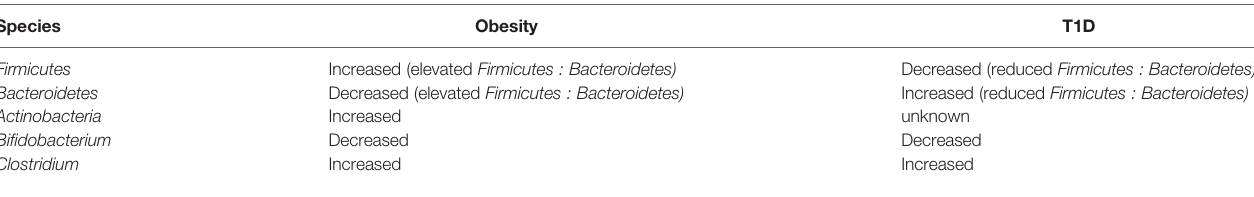
TABLE 2 | Table highlighting some similarities and differences in bacterial species seen in obesity and in type 1 diabetes. Species